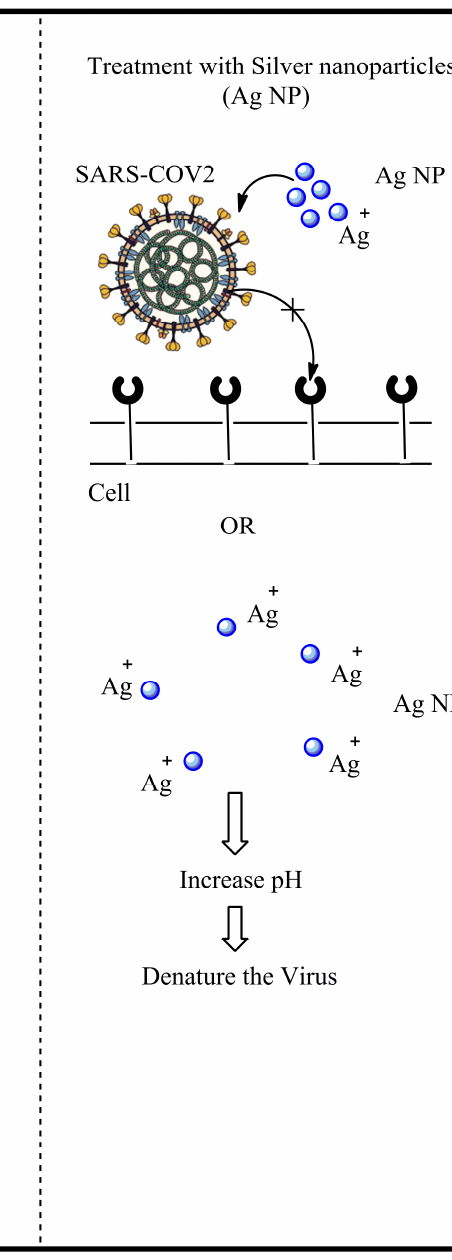
Figure 4. The proposed possible mechanism of action towards severe acute respiratory syndrome coronavirus 2 (SARS-CoV 2).